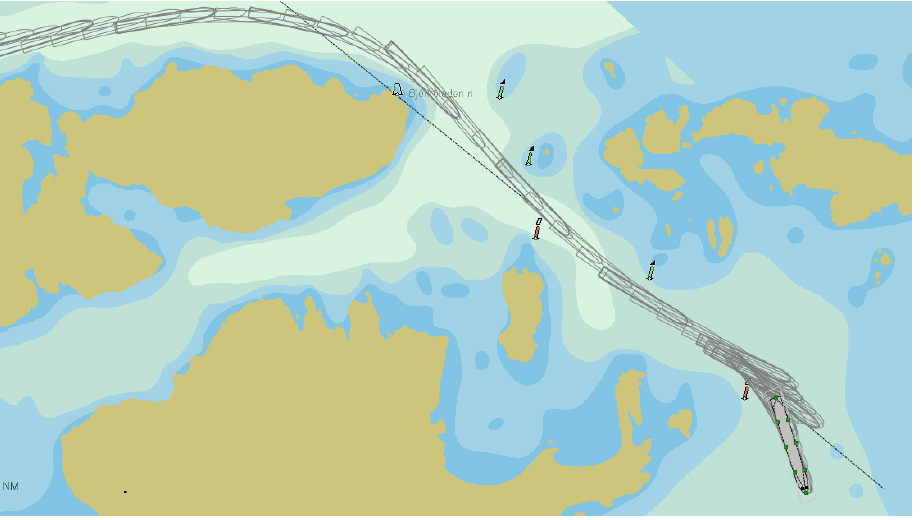
Figure 8. The navigational channel near Korsakobben Island and ship’s trajectory (Stockholm archipelago), where: buoys on chart are marked in black [73].